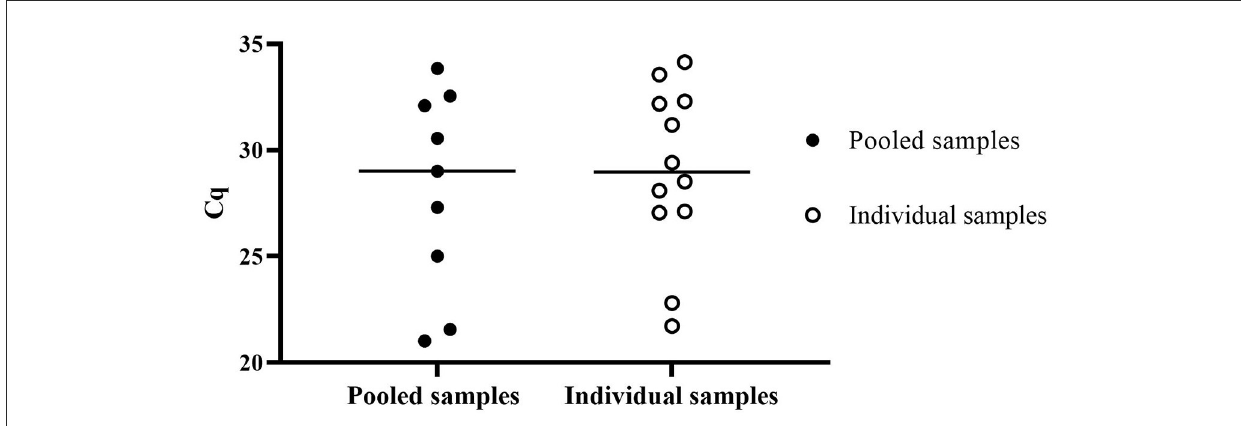
FIGURE4 Surveillance data of positive Cq value of T. foetus direct RT-qPCR of pooled samples and individual samples submitted from October 2020 to October 2022.